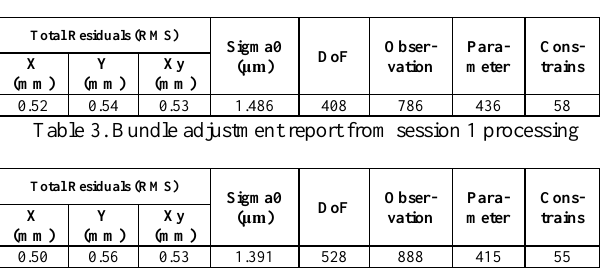
Table 4. Bundle adjustment report from session 2